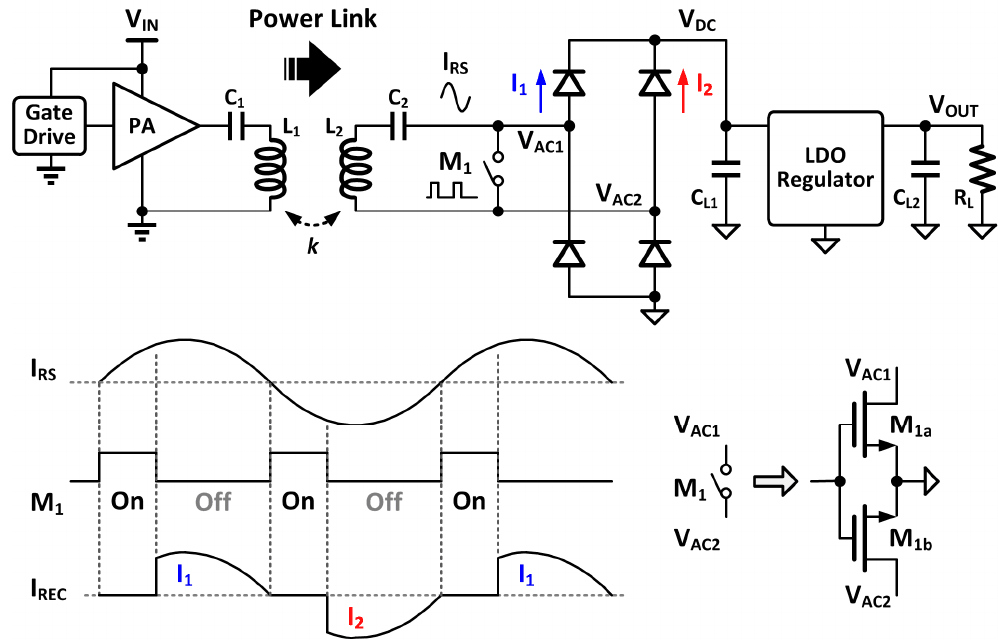
Figure 11. A WPT receiver with PWM pre-rectifier regulation [20,21].